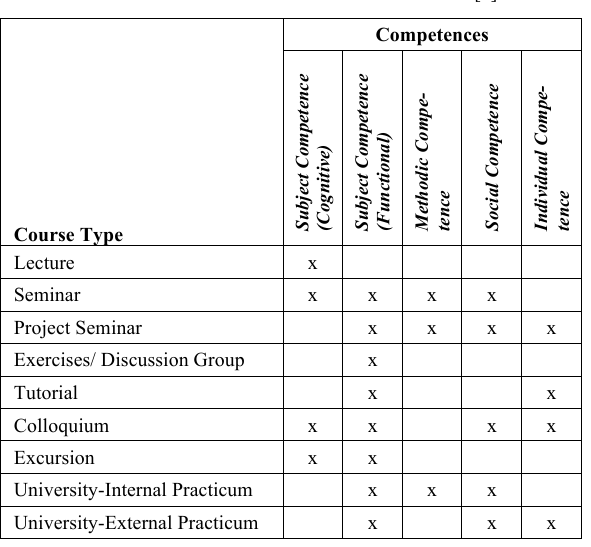
TABLE I. A SSIGNMENT OF C OMPETENCES A CCORDING TO